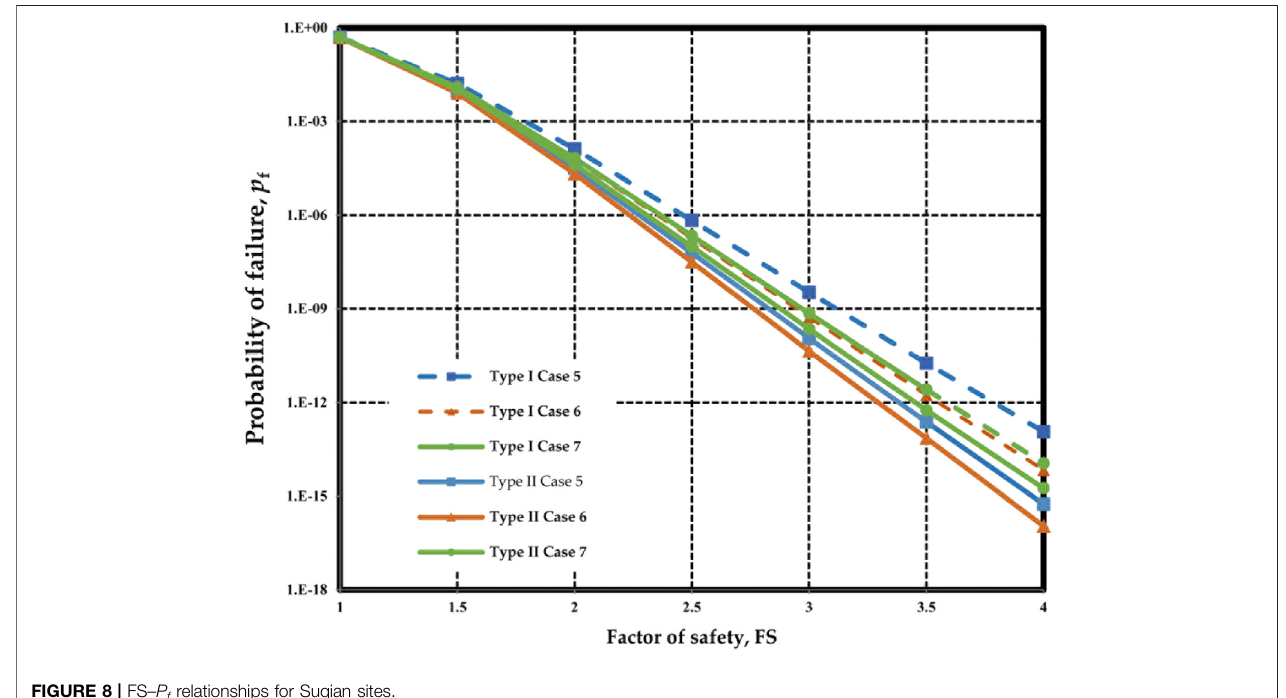
FIGURE 8 | FS – P f relationships for Suqian sites.